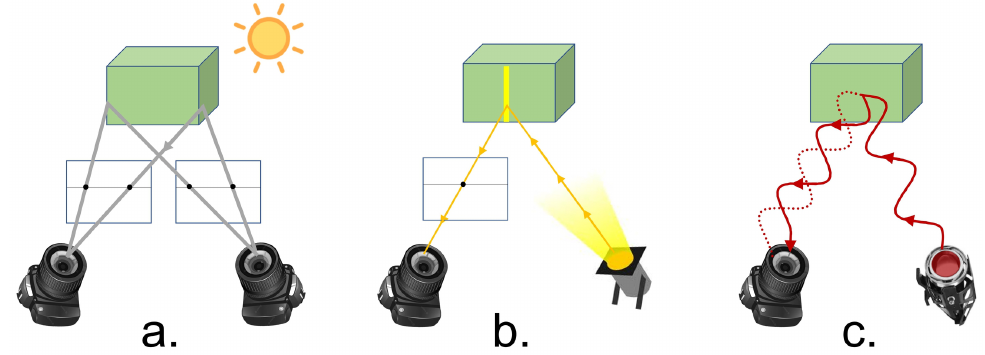
Figure 2. Depth Sensing technologies. ( a ) Passive stereo. ( b ) Structured light. ( c ) Time of